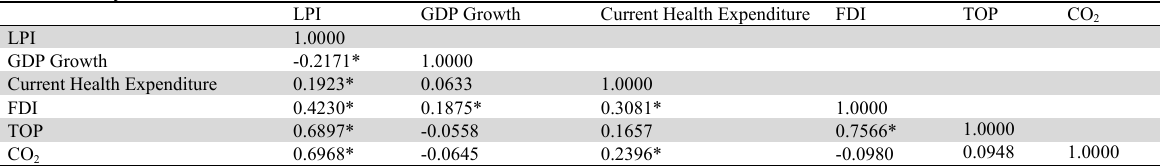
The summary of the correlation